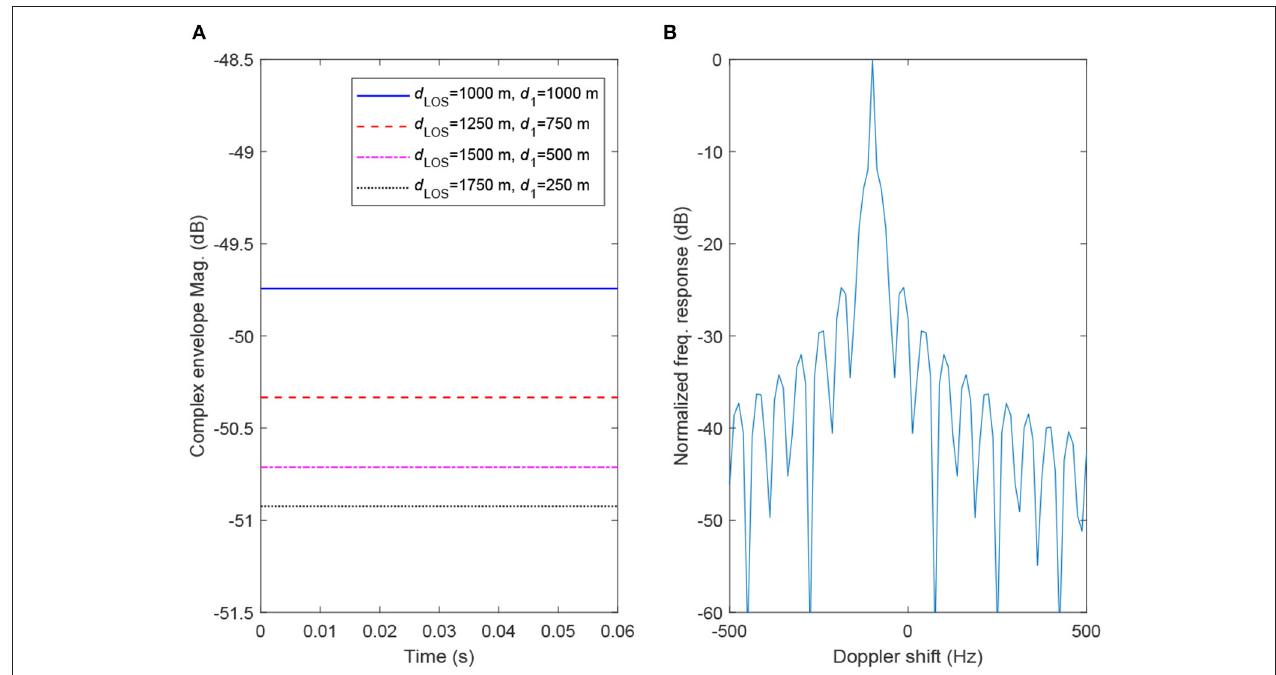
FIGURE 4 | (A) Maximized magnitude of the received signal in the presence of an RIS, (B) Doppler spectrum of the received signal for all scenarios.